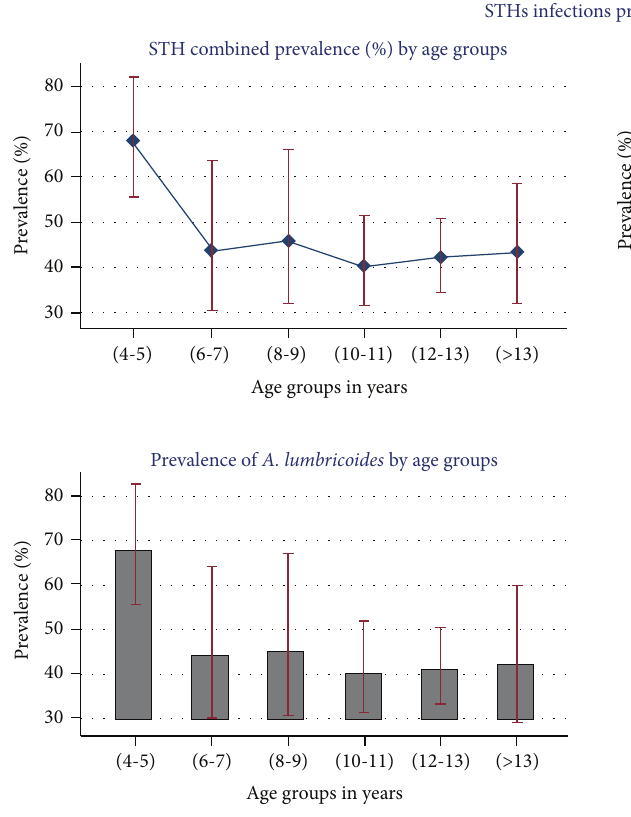
Figure 2: Prevalence (%) of various STHs species by age